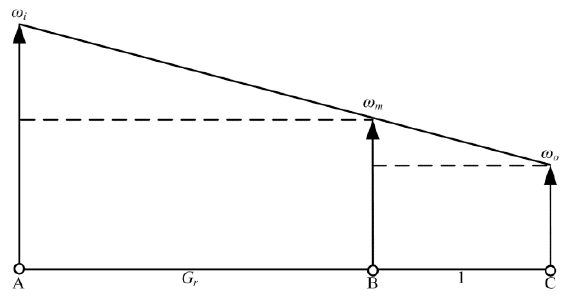
Figure 2. Collinear speed map.